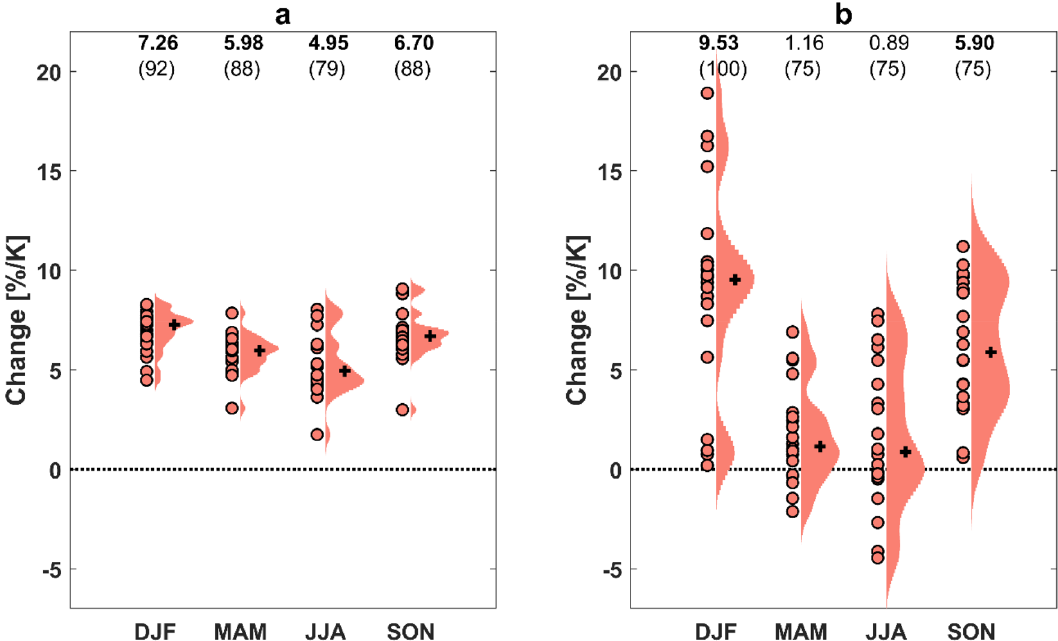
Figure 4. Changes in 1-in-30-year ( a ) extreme precipitation and ( b ) flood intensity per season (salmon dots, individual models) in the Northern Hemisphere mid-latitudes. For each violin, ensemble median is shown by black cross. The numbers on top of the violins (top row) indicate ensemble median and those in bold face and italic denote significant changes at the 95% and 90% confidence levels, respectively. The numbers in brackets indicate the percentage of experiments that agree on the sign of change